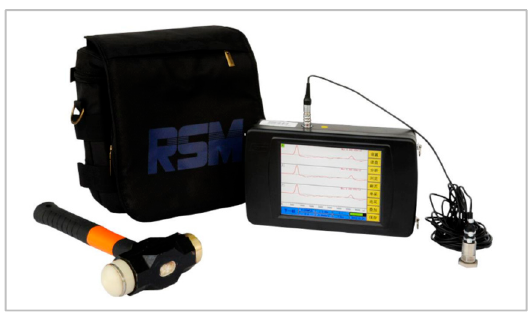
Figure 6. Our LSPIT equipment.